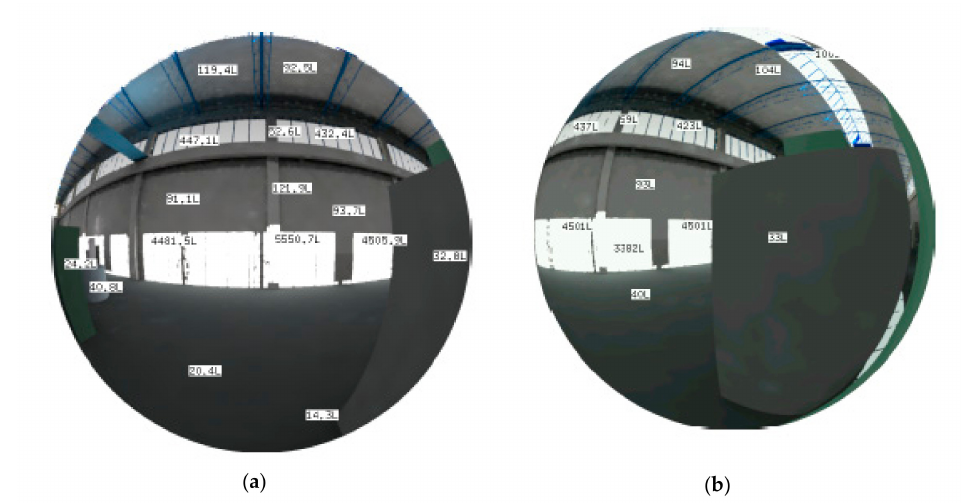
Figure 8. Result of simulated point values of brightness (luminance value cd.m − 2 ) at the workplace using wire skylight glazing: ( a ) sunny sky, north view; ( b ) sunny sky, northeast view.